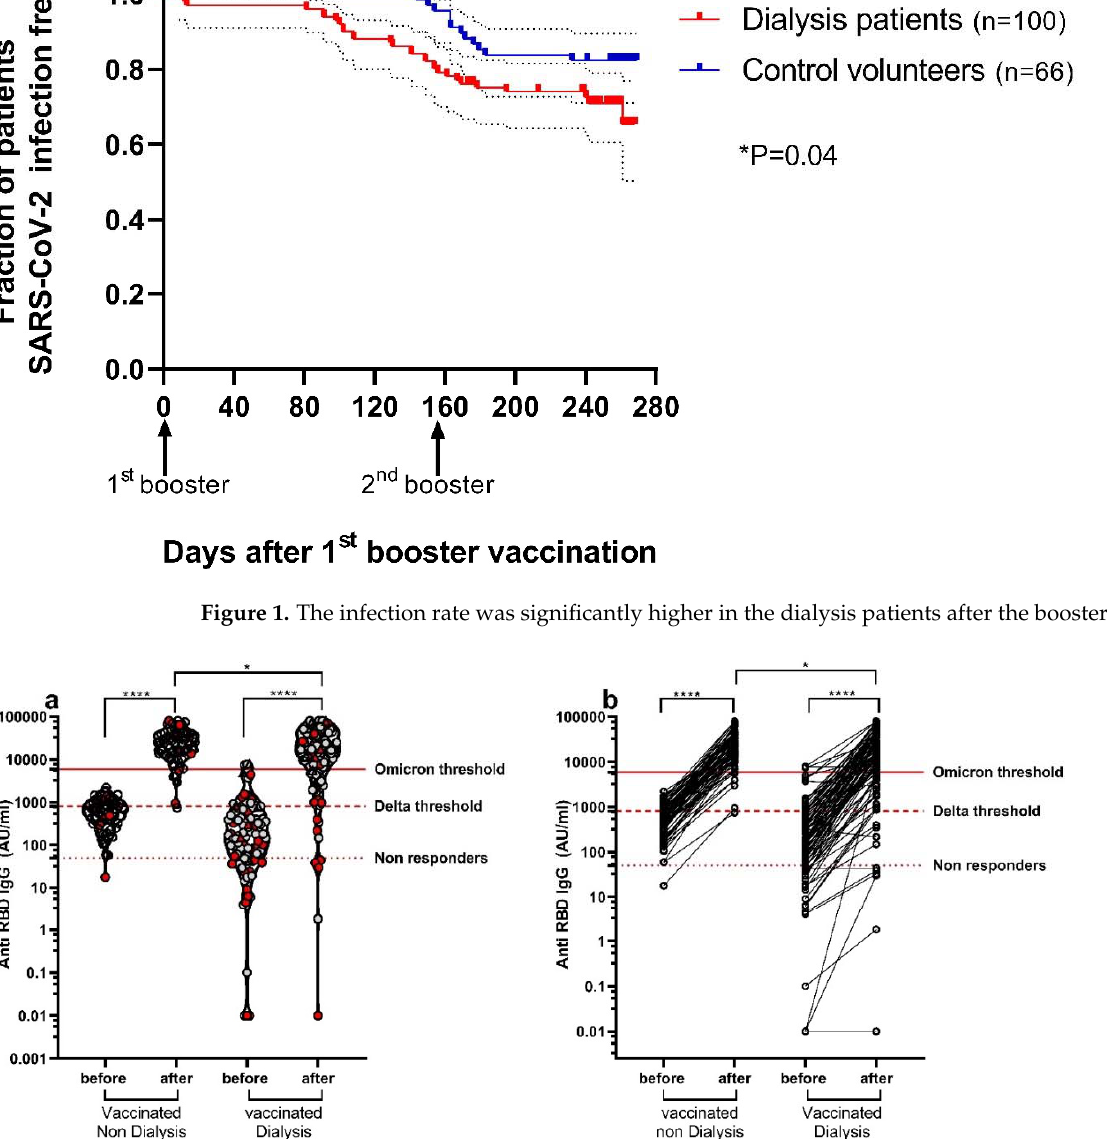
Figure 1. The infection rate was significantly higher in the dialysis patients after the booster dose. Fraction of 100 dialysis patients (red) and 66 control volunteers (blue) with SARS ‐ CoV ‐ 2 infection after the first booster vaccination (95% CI). The anti ‐ SARS ‐ CoV ‐ 2 spike1 IgG antibody titer was significantly upregulated after